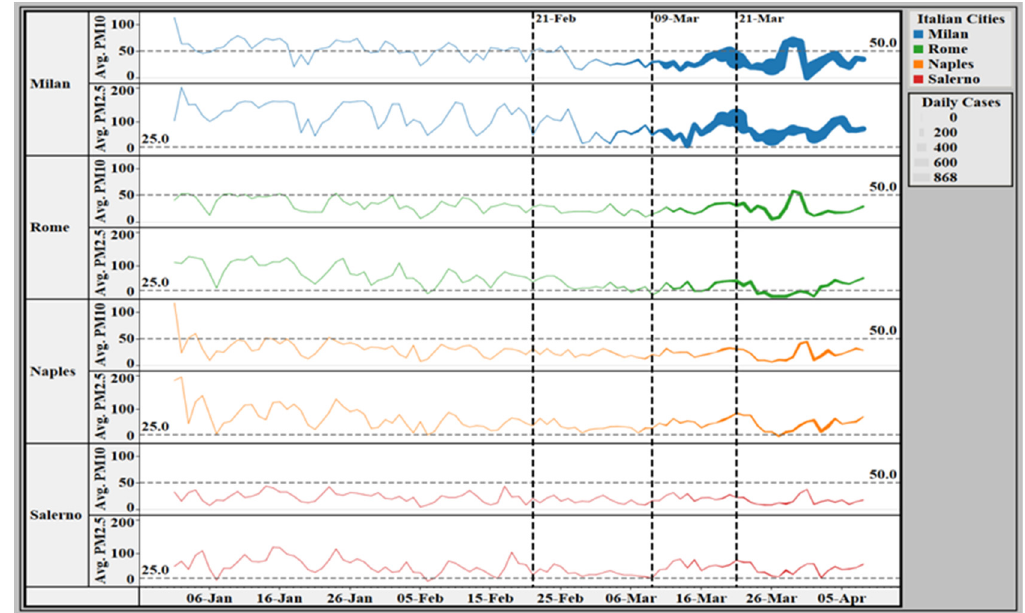
Figure 2. Average daily concentrations of PM 10 and PM 2.5 applied to the daily average of new COVID-19 cases (line width) in Milan, Rome, Naples, and Salerno for the period from 1 January 2020 to 8 April 2020.